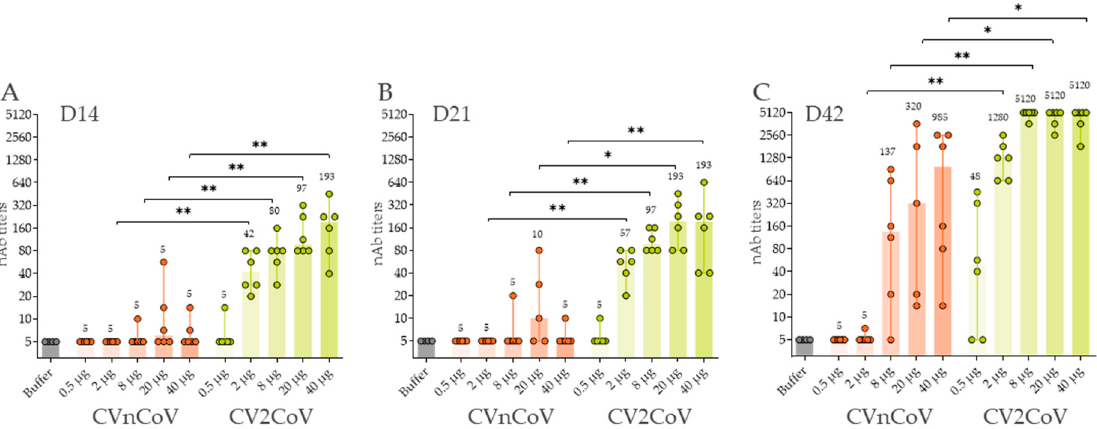
Figure 2. CV2CoV induced higher levels of antibodies against the S receptor-binding domain (SRBD) than CVnCoV in rats. Groups of female and male Wistar rats ( n = 6/group) were vaccinated IM on day (D)0 and D21 with five different doses ranging from 0.5 μ g to 40 μ g of CVnCoV or CV2CoV. Wistar rats ( n = 4) vaccinated with 0.9% NaCl (Buffer) on D0 and D21 served as negative controls. SRBD-specific antibody responses are shown as endpoint titres for IgG1 and IgG2a in serum after one dose (( A ) D14 and ( B ) D21) or two doses (( C ) D42). Each dot represents an individual animal, and the vertical lines show the range. A Mann–Whitney test was used to compare the groups: ns = >0.5, * = p < 0.05, ** = p < 0.01.